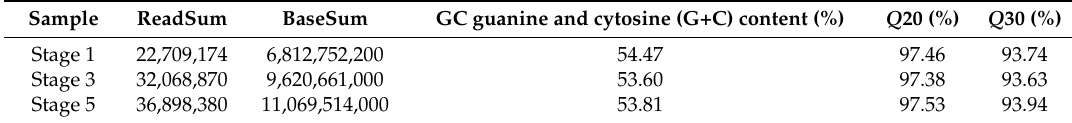
Figure 1. Transverse sections in middle sections of MBSes for three phases. The vascular bundles were stained blue. It showed no blue in color on day 0, whereas the vessels were stained from faint blue to oxford blue in the following two stages. Table 2. Evaluation statistics of sequencing data in the three stages of 4 °C.